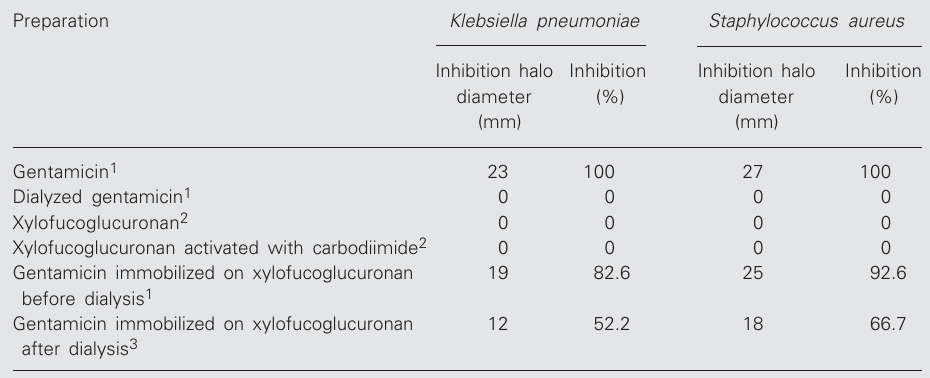
Table 1. Sensitivity of Klebsiella pneumoniae and Staphylococcus aureus to gentamicin immobilized on xylofucoglucuronan.